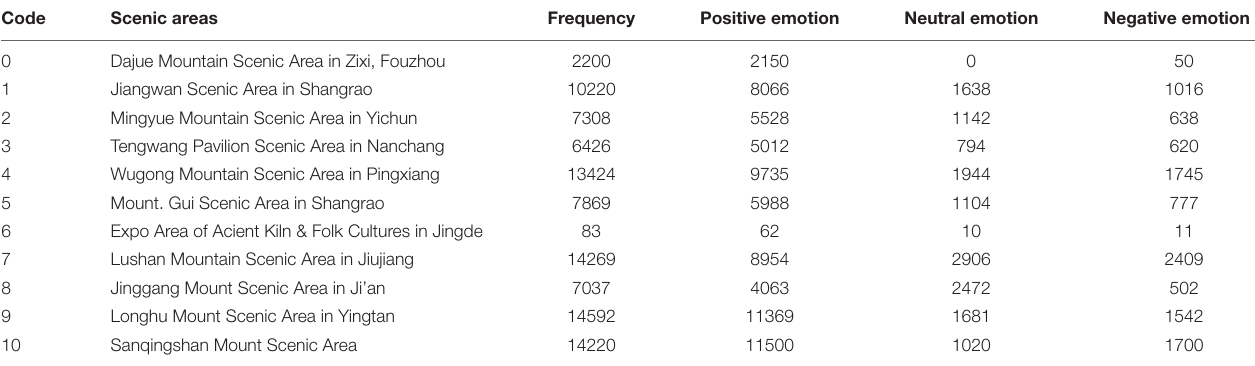
TABLE 6 | The mechanism of point and line